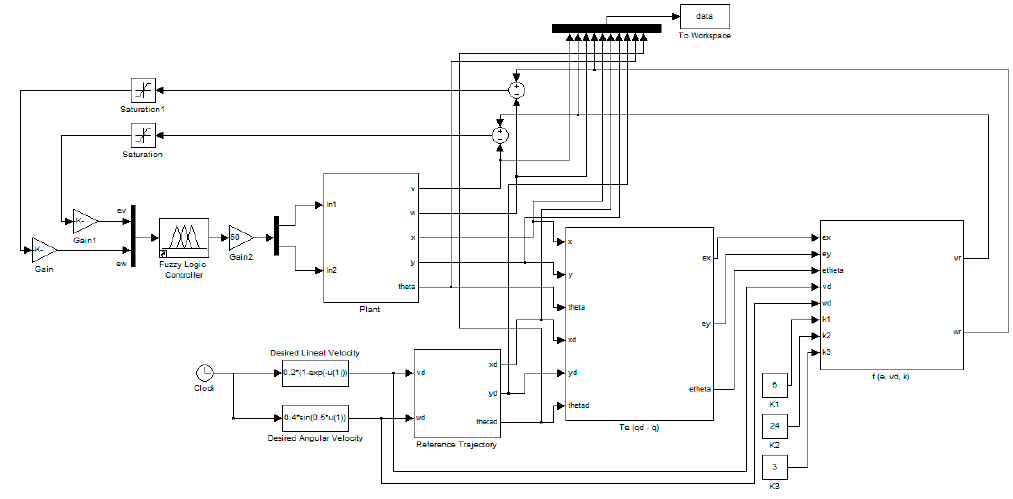
Figure 8. Complex plant for an autonomous mobile robot.